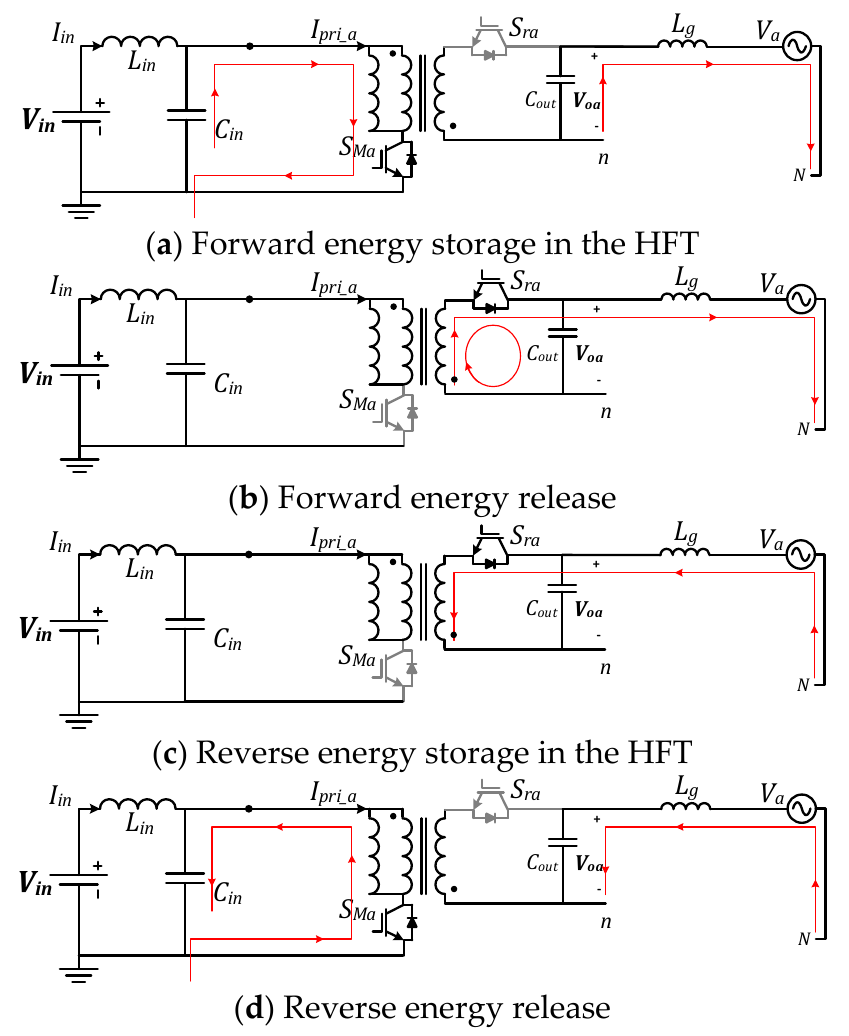
Figure 2. Temporary power transfer in a single module of the IFBI.